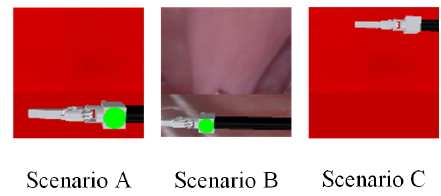
Figure 10. Laparoscopic field of view in different